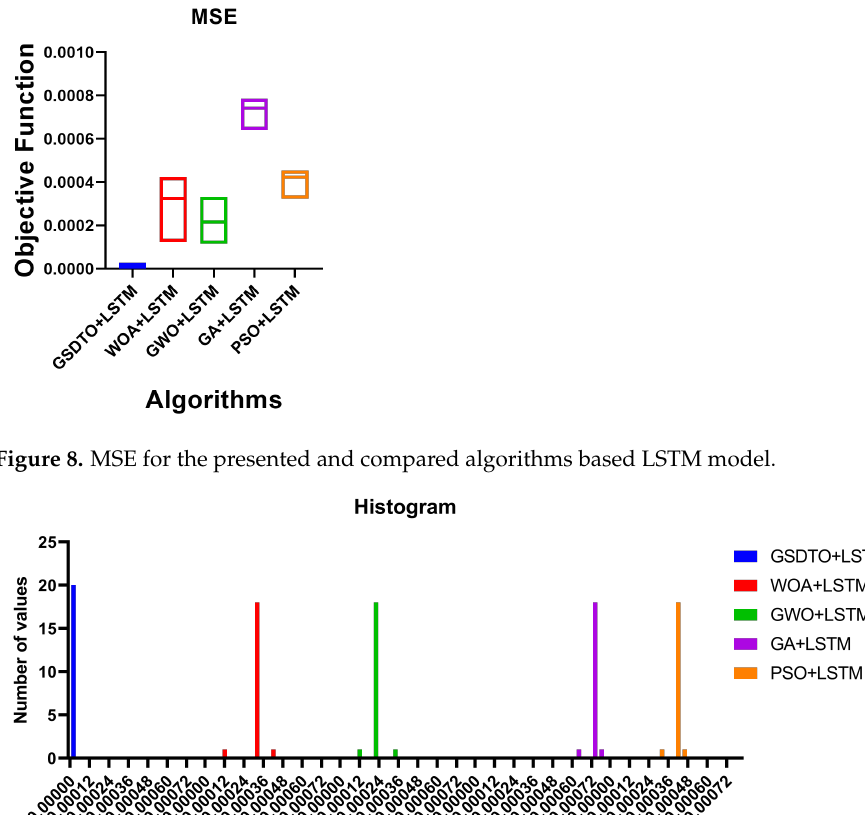
Figure 7. Comparison of the presented and compared algorithms convergence curves based LSTM model.